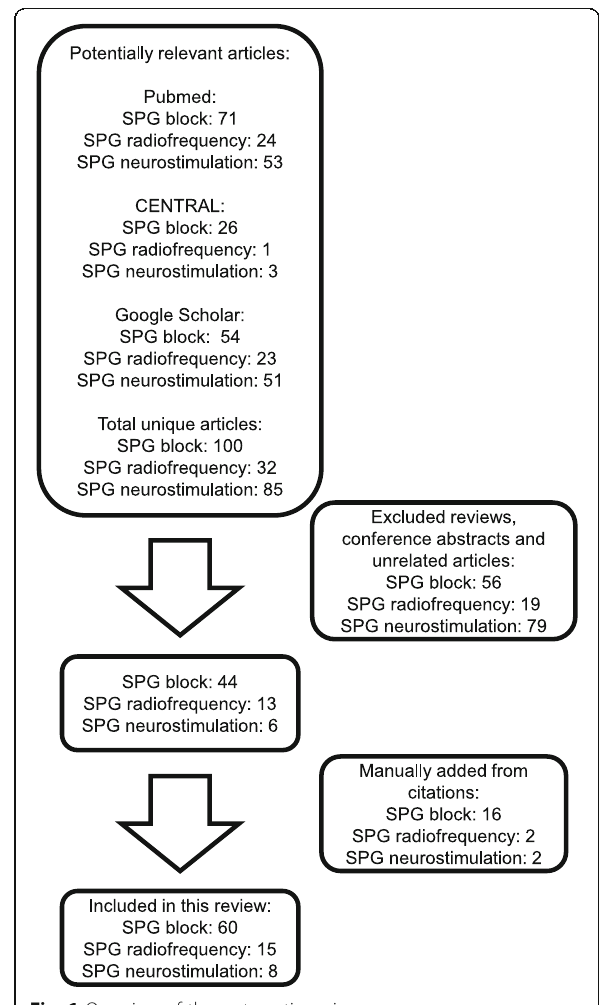
Fig. 1 Overview of the systematic review